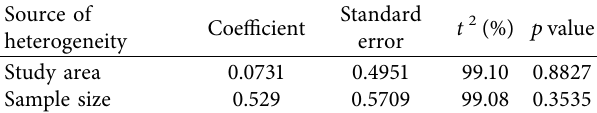
Figure 3: Funnel plot of the included studies. Table 3: Sources of heterogeneity across the studies. Source of heterogeneity